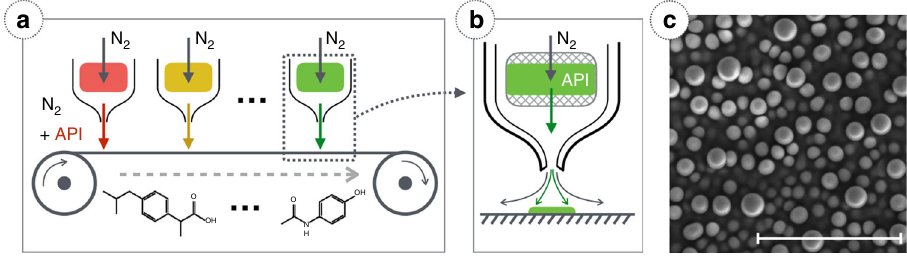
Fig. 1 OVJP system schematic. a , b — OVJP operation principle. Inert carrier gas passes through an evaporation zone picking up the organic vapor and jetting onto a cooled substrate where the organic molecules selectively condense. c Fluorescein nanolobes grown by OVJP. Scale bar 5 μ